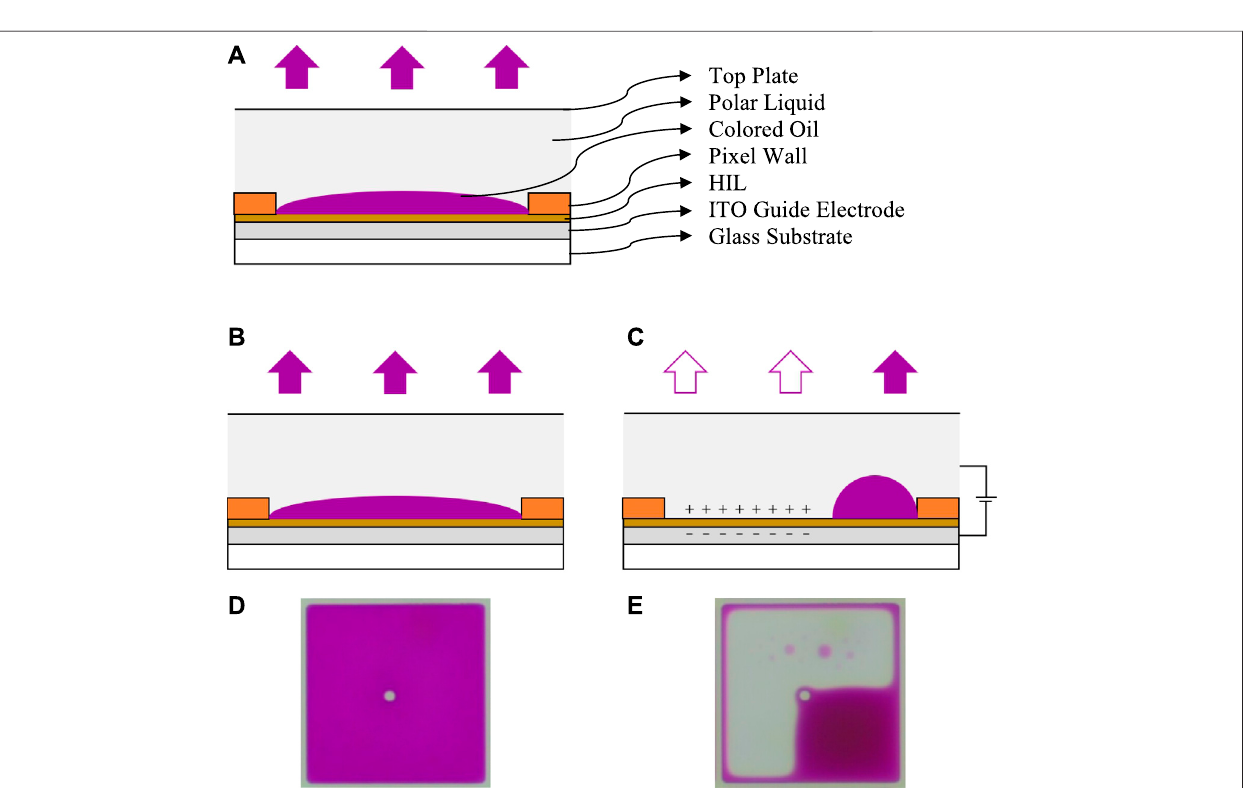
FIGURE 1 | Principle of the EWD. (A) Pixel structure of the EWD. (B) Without an applied external voltage, the color of oil is displayed in a pixel (C) With an applied external voltage, the color of substrate is displayed. (D) The top view when the pixel is turned off. (E) The top view when the pixel is turned on.